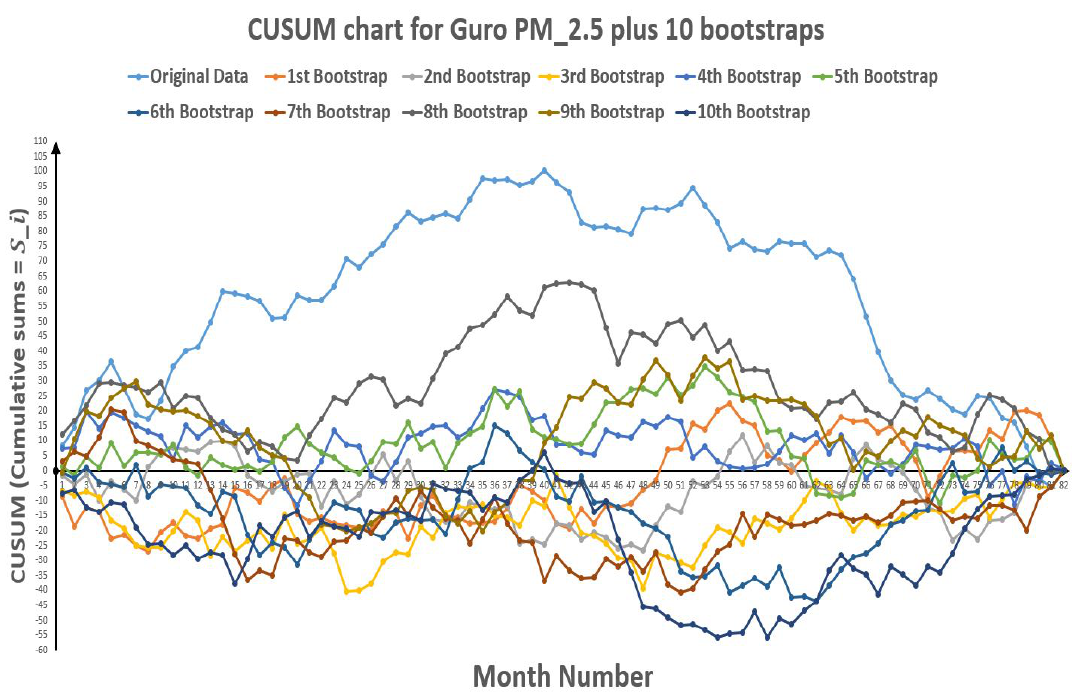
Figure 10. CUSUM chart for Guro PM 2.5 plus 10 bootstraps (European Standards).